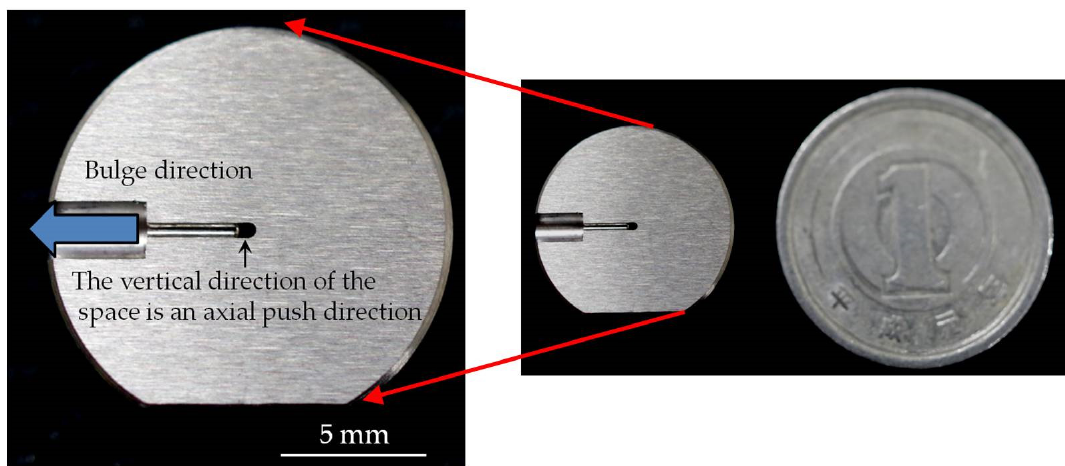
Figure 2. Geometry and dimensions of die and axial punch used for a microtube hydroforming